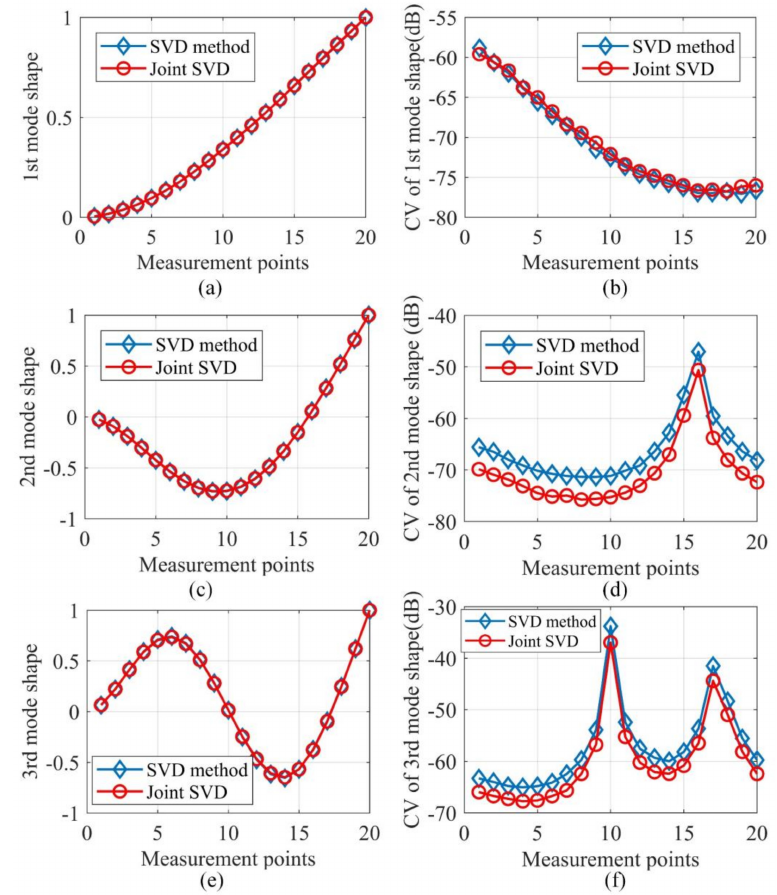
Figure 3. Estimated mode shapes and their CVs for the first three modes: ( a ) the 1st mode shape; ( b ) CV of the 1st mode shape; ( c ) the 2nd mode shape; ( d ) CV of the 2nd mode shape; ( e ) the 3rd mode shape; ( f ) CV of the 3rd mode